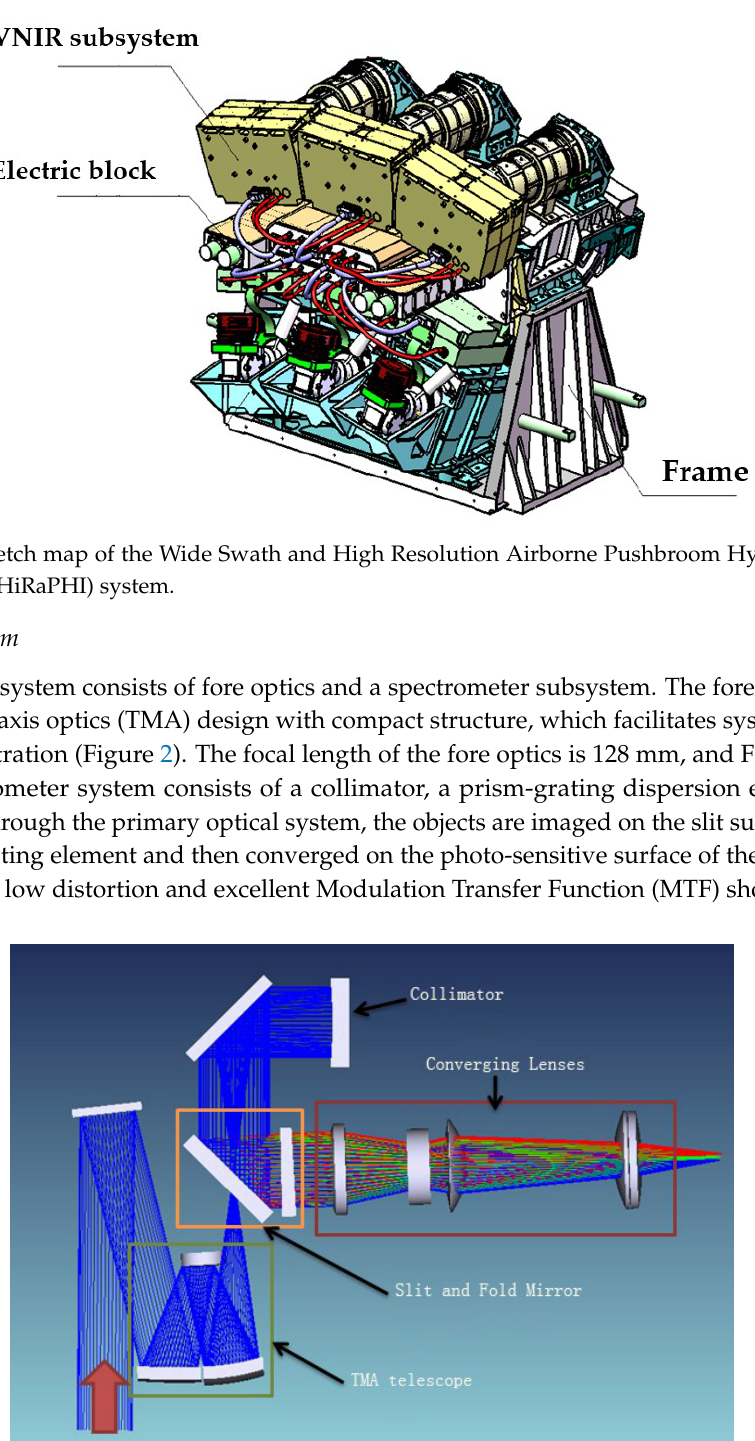
Figure 1. Sketch map of the Wide Swath and High Resolution Airborne Pushbroom Hyperspectral Imager (WiSHiRaPHI) system.